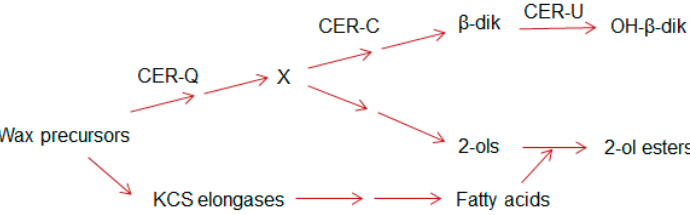
Figure 2. Sites of action of the Cer-c , -q and – u encoded proteins based on compositional analyses of the waxes of wild type and cer mutants with CER-U functioning as a hydroxylase; simplified from [16]. X denotes a common precursor for both the β -diketone aliphatics and the esterified alkan-2-ols. KCS elongases denote the elongation systems giving rise to the ubiquitous wax aliphatics.